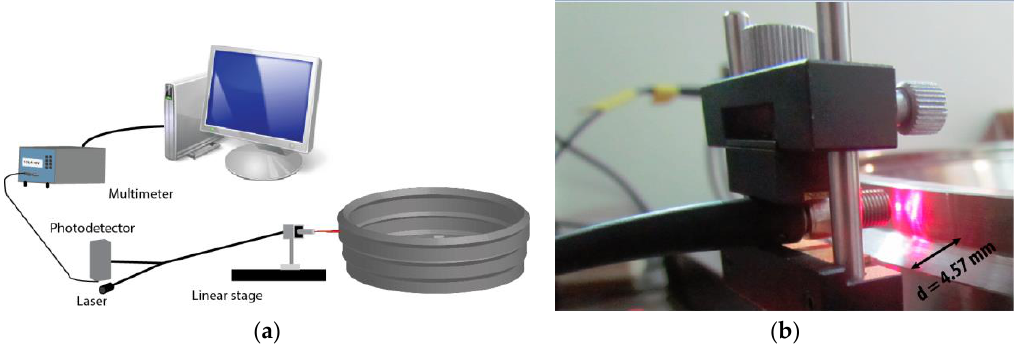
Figure 4. Sensor calibration process ( a ) and detail of the tip of the OFS illuminating the rotating disk during the calibration process ( b ).